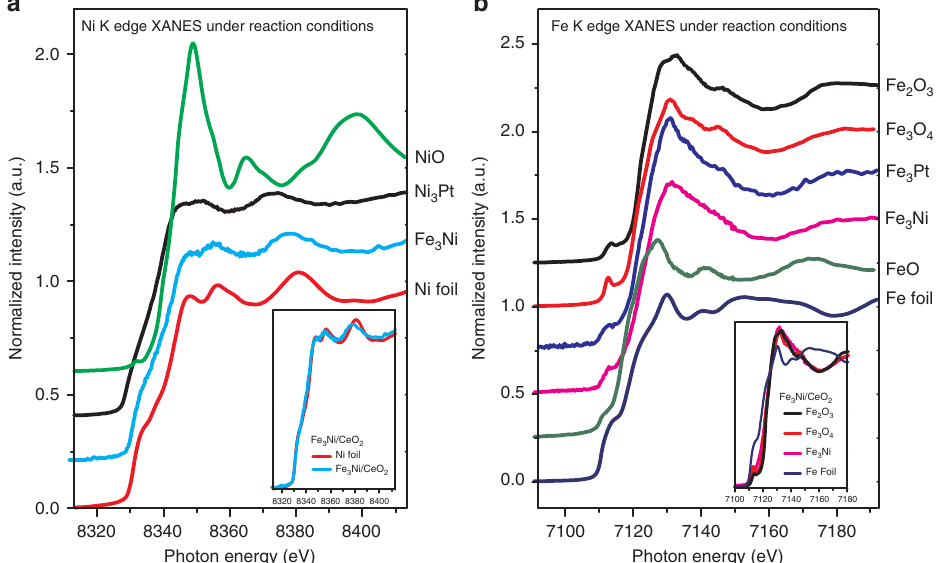
Fig. 3 In-situ XANES spectra. a Ni and b Fe K edges of all the bimetallic catalysts with respective references. The insets show more detailed comparison of Fe 3 Ni with model